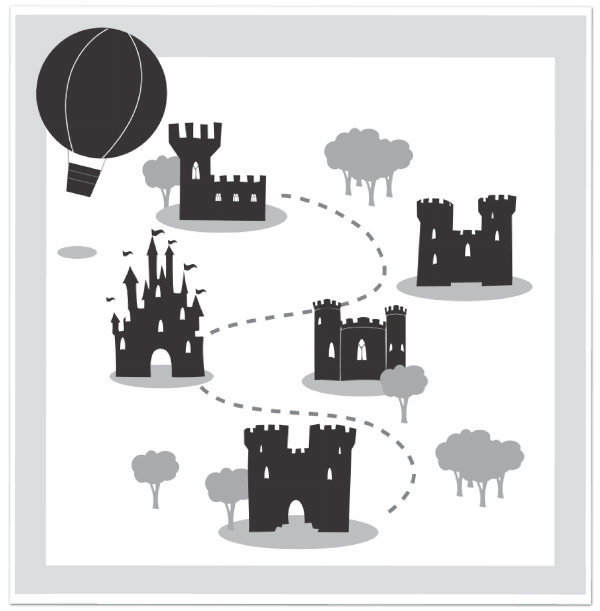
Figure 11. Five kingdoms of feelings, science, history, music and fantasy (illustration and graphic project made by Giacomo Guc- cinelli and Lucrezia Benvenuti; Locritani et al.,